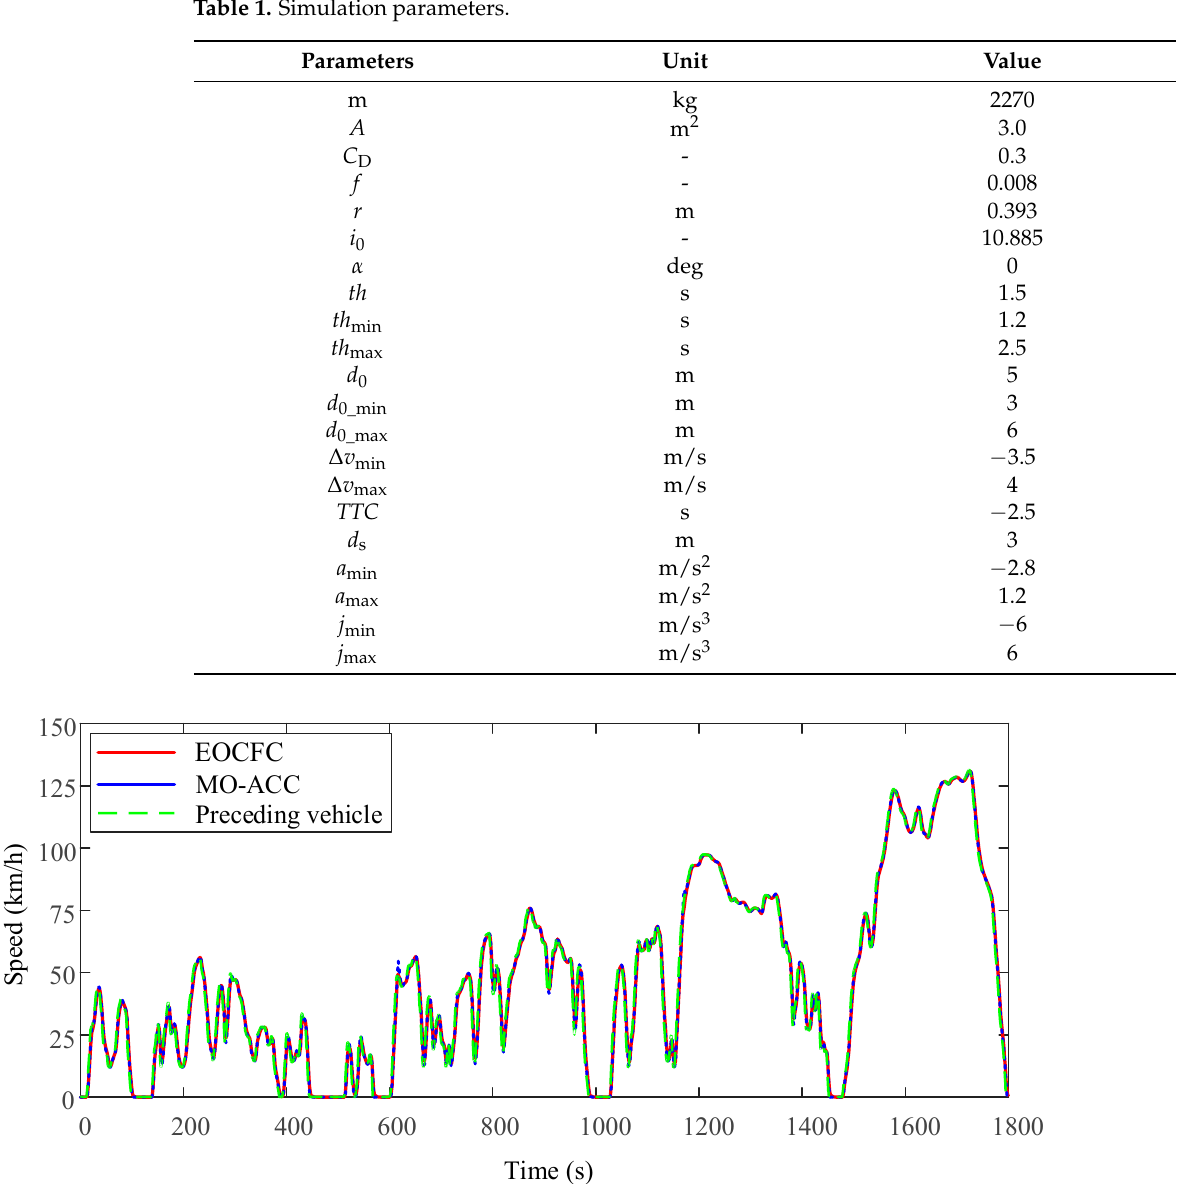
Figure 8. Speed profile of the host vehicle resulting from the MO-ACC strategy and the EOCFC strategy under the WLTC test cycle.